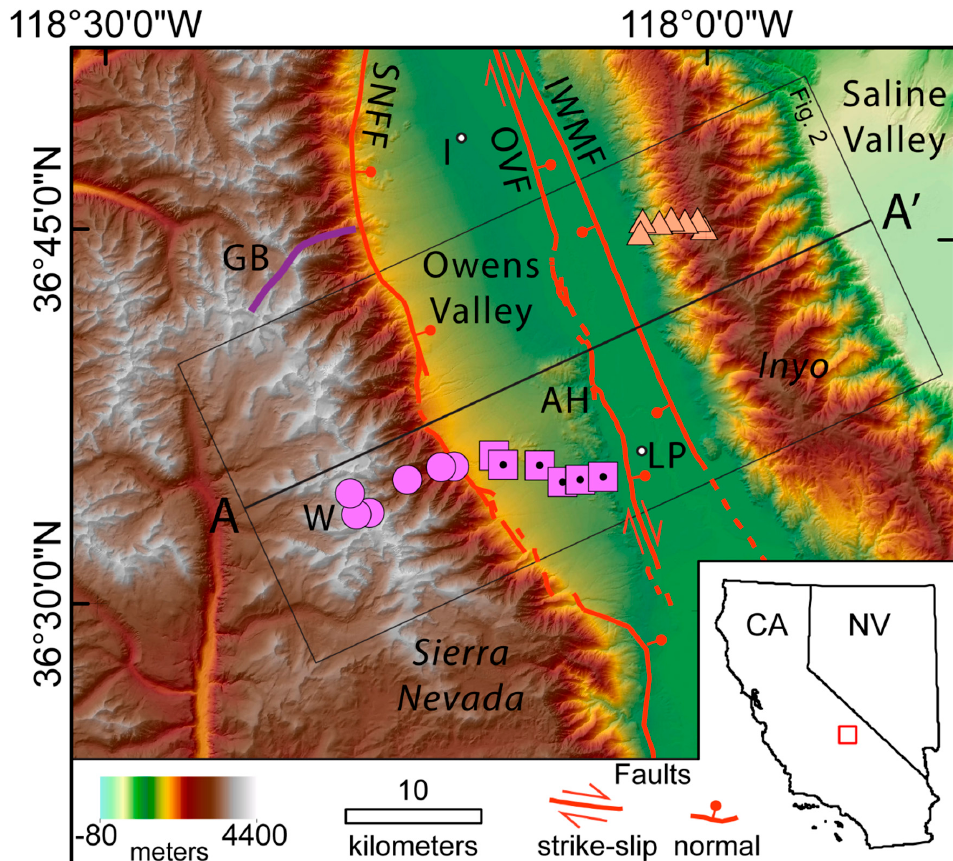
Figure 1. Overview map of Owens Valley, California in the vicinity of the Alabama Hills (AH). Base imagery is 10-m digital elevation model overlain with partially transparent hillshade. Extent and center line of the area used for topographic swath profile A–A’ (Figure 2) are shown in black lines. (U-Th)/He sample sites are symbolized according to data source. Purple solid circles: Mount Whitney data [9] . Purple squares with black dot: Alabama Hills data [10] . Salmon solid triangles: Inyo Mountains data [11] . OVF: Owens Valley Fault [12,13] . SNFF: Sierra Nevada Frontal Fault [11,12] .